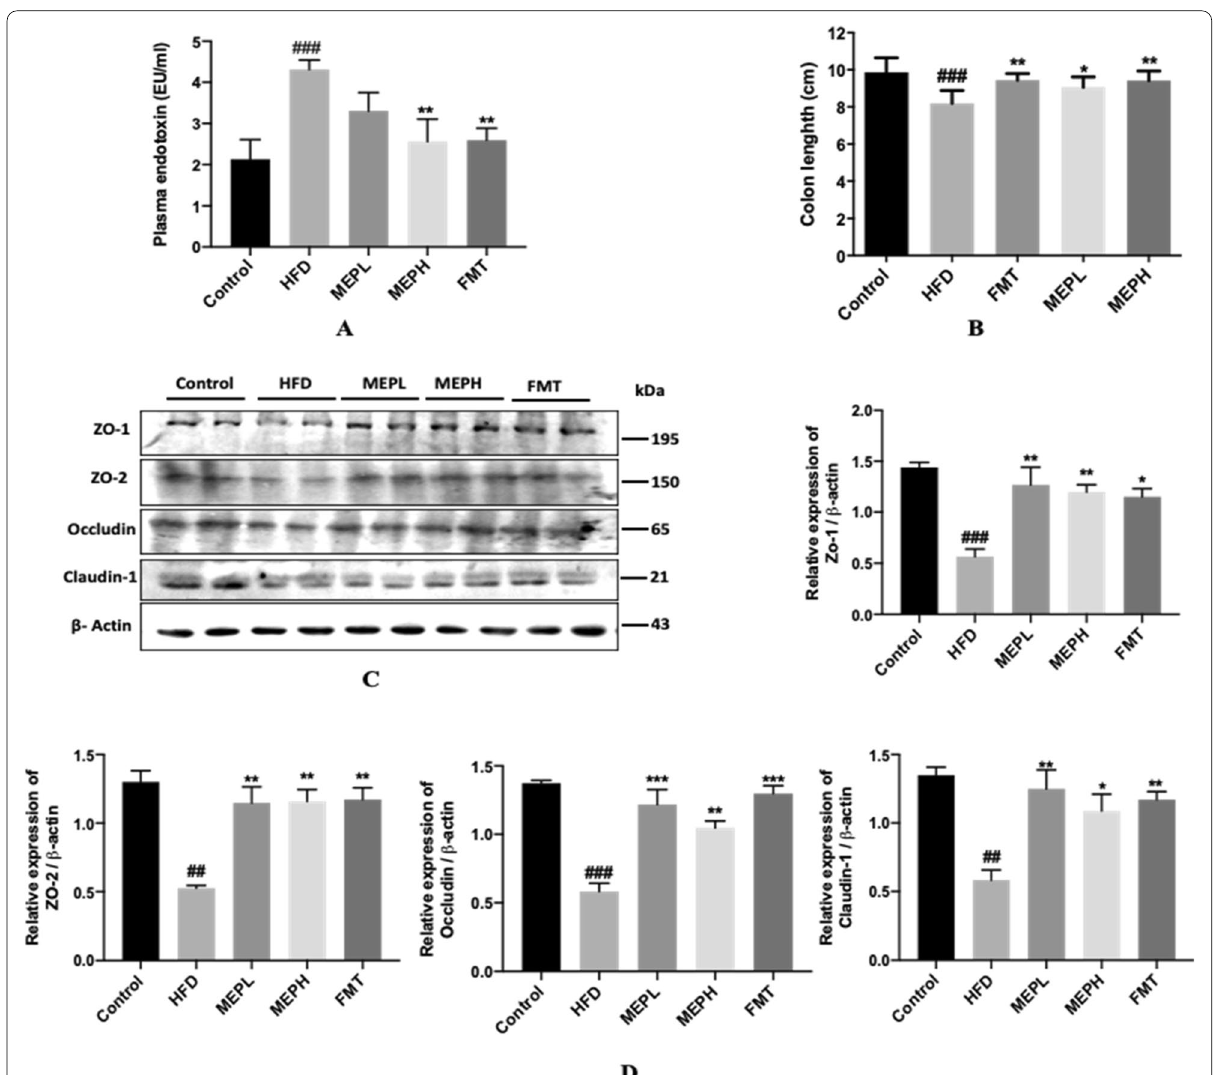
Fig. 5 Effect of MEP on endotoxemia and Tight Junction-related Protein (TJP) in obesogenic mice. A The colon’s length was measured in centimeters. B The effect of MEP treatment on LPS levels of serum endotoxin (EU/ml) was measured by the limulus amebocyte lysate test kit. C TJP (ZO-1, ZO-2, occludin, and claudin-1) immunoblots from colon tissues in different MEP treatment groups. D Bar graph shows the relative band strength of the respective protein against β-actin as an internal control quantified by image J software. The data was obtained by three independent experiments and is expressed as mean SEM (n 8). Significant differences were presented using at # p < 0.05, ## p < 0.01, ### p < 0.001 ± = and #### p < 0.0001 vs. Control group and *p < 0.05, **p < 0.01 and ***p < 0.001 and **** p < 0.0001 vs. HFD